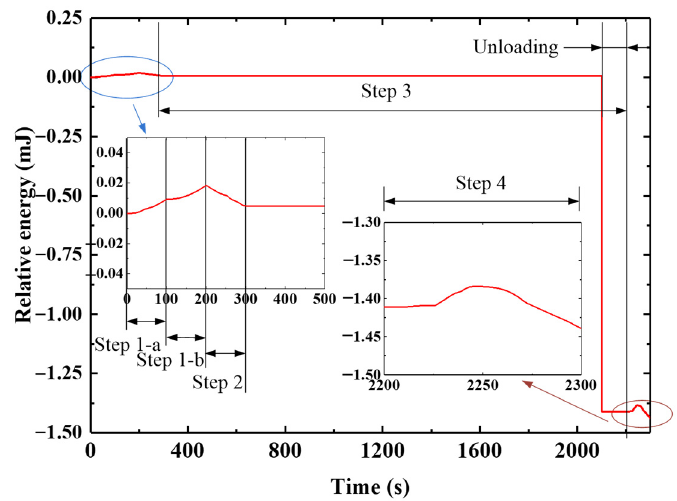
Figure 23. Internal response energy curve for the F-DS.